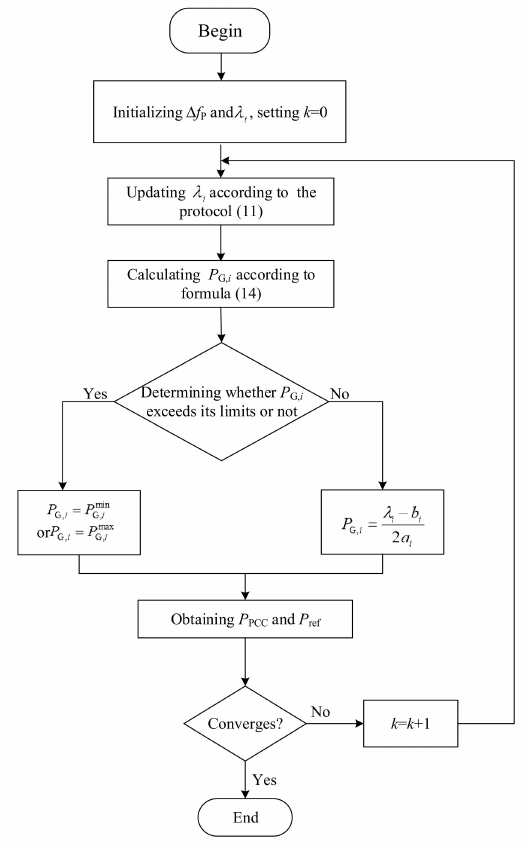
Figure 2. Flow chat of the real-time distributed economic dispatch (ED)